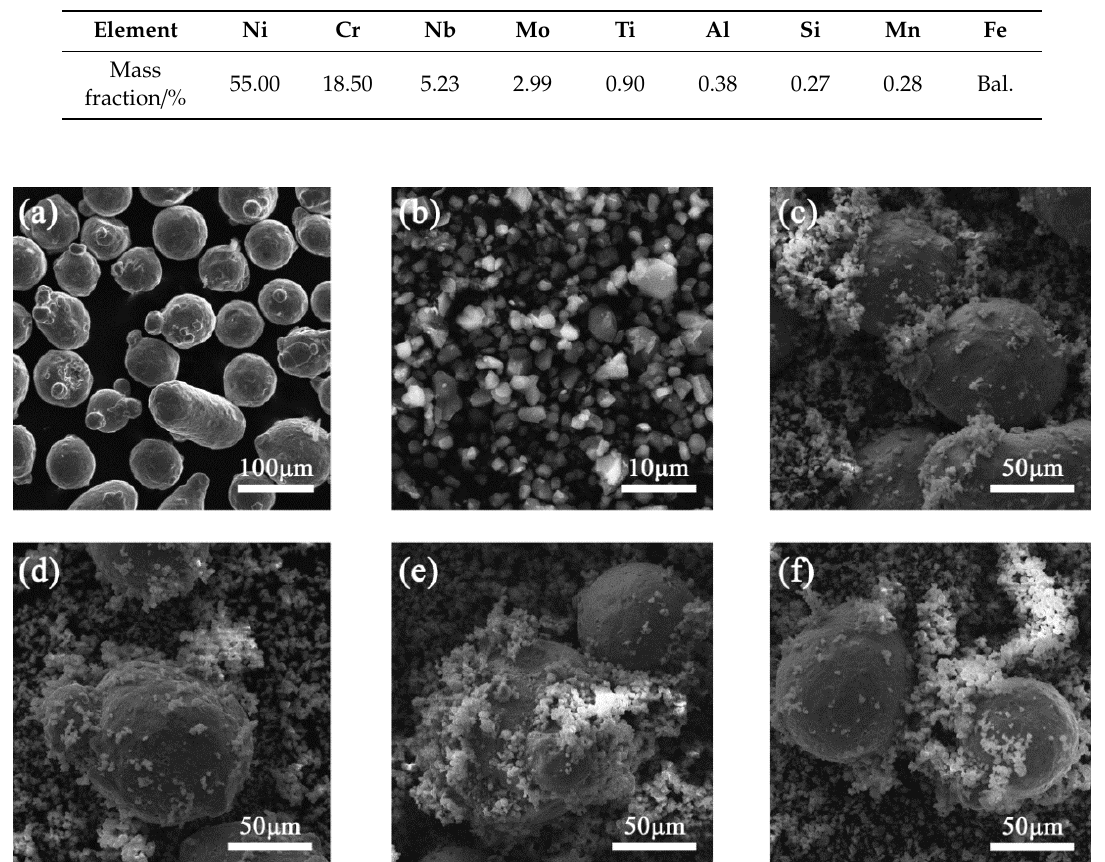
Figure 1. SEM morphologies of ( a ) Inconel 718 alloy powder, ( b ) TiB 2 particles and mixed powder: ( c ) TB10, ( d ) TB20, ( e ) TB30, ( f ) TB40.